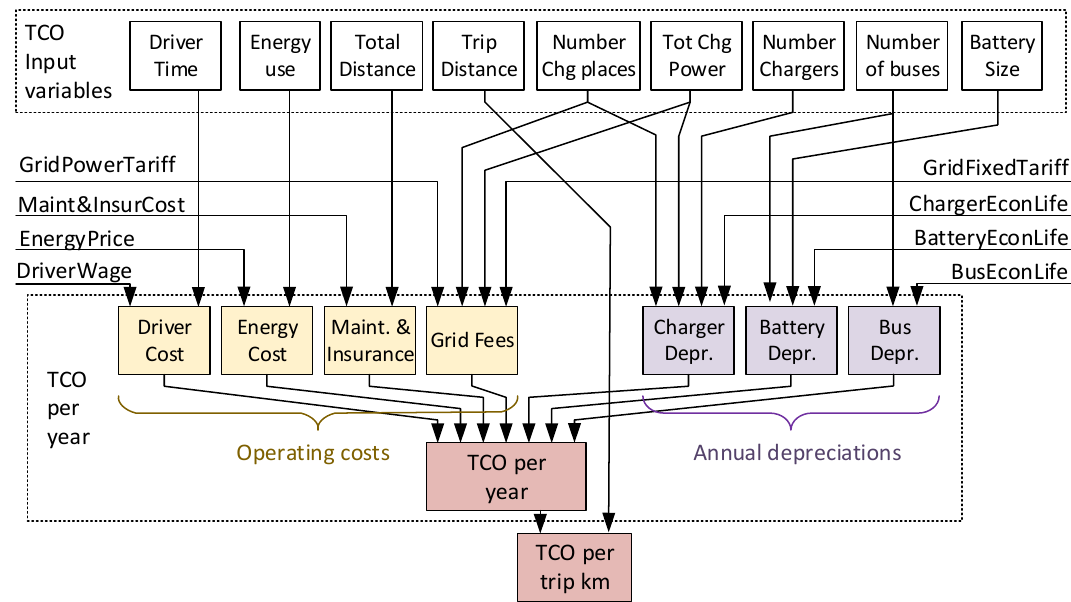
Figure 1. The calculation steps of the TCO model, its nine input variables in the white boxes at the top and its eight cost parameters as inputs from the left and right side of the model.